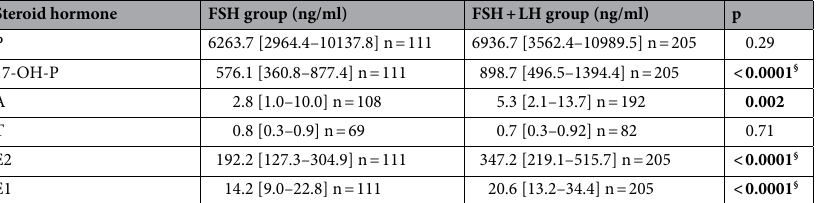
Table 2. Median values [IQR] of Progesterone (P), 17α-Hydroxyprogesterone (17-OH-P), Androstenedione (A), Testosterone (T), Estradiol (E2) and Estrone (E1) FF levels, measured by HPLC–MS/MS, in the two groups of ovarian stimulation (FSH and FSH + LH). p column indicates the statistical significance between the two groups of ovarian stimulation. In bold statistically significant differences. § Statistical significance was maintained after adjustment for female age.